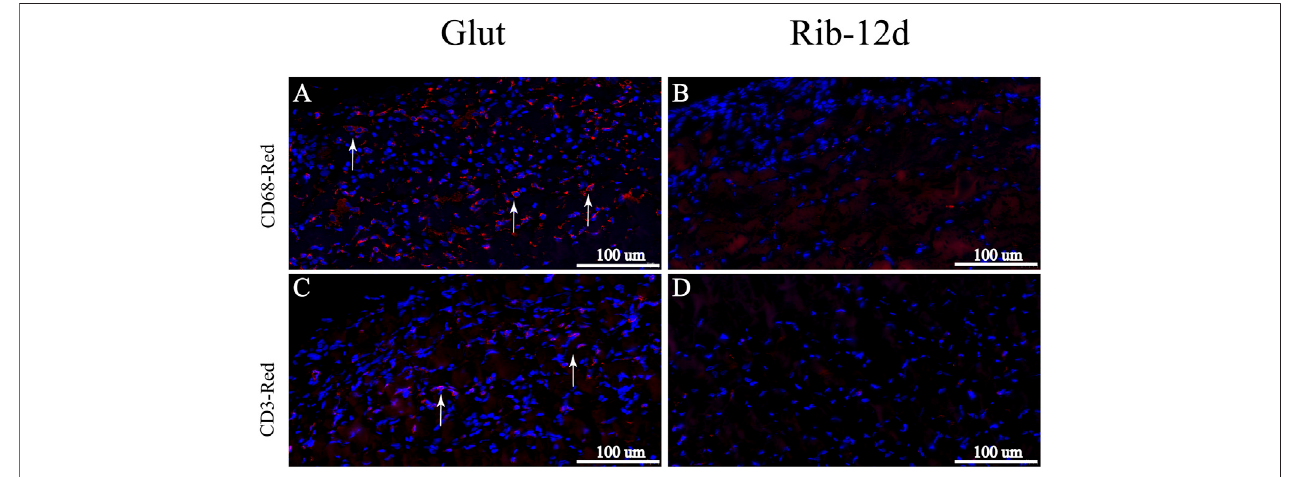
FIGURE 11 | Immunological characterization of the in fl ammatory response of BP implanted into rats for 90 days. (A,B) IHC images. Macrophages were labeled with the CD68 marker and stained red (white arrow). (C,D) IHC images. T cells were labeled with the CD3 marker and stained red (white arrow). Scale bars: 100 μ m (A – D)